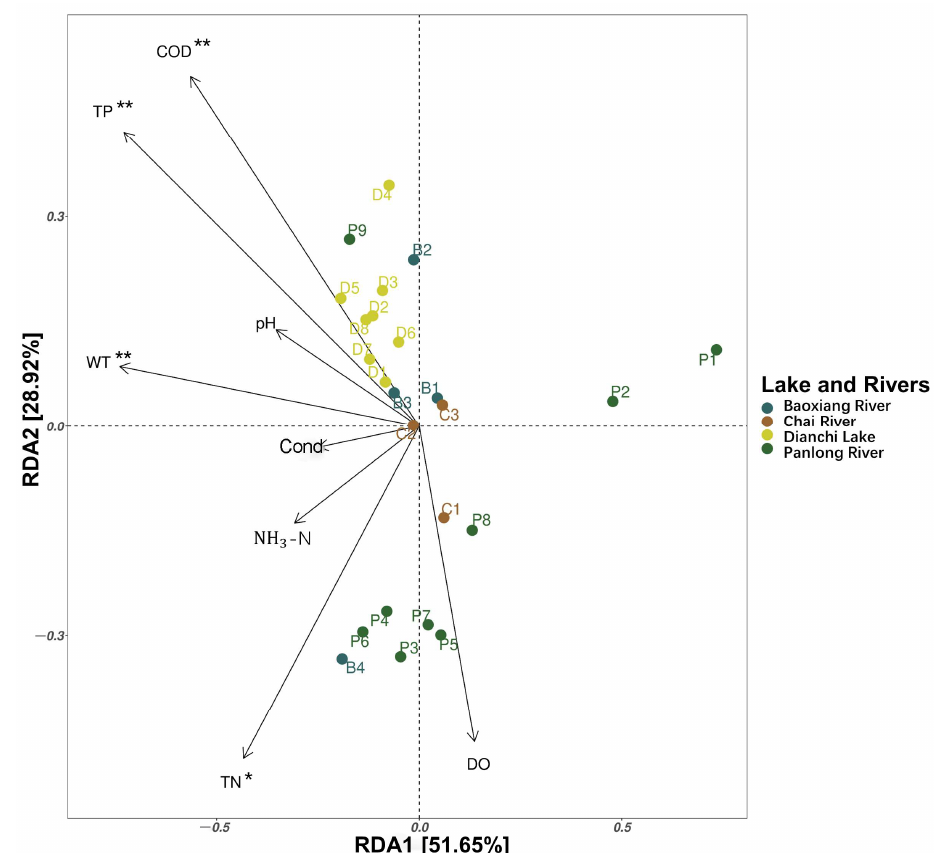
Figure 5. Redundancy analysis of the sampling point and environmental factors; * means significant affection at 0.05 level, ** means significant affection at 0.01 level.